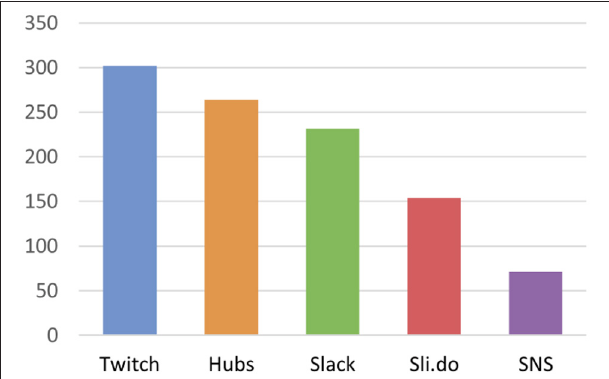
FIGURE 3 | Aggregated distribution of platforms used during